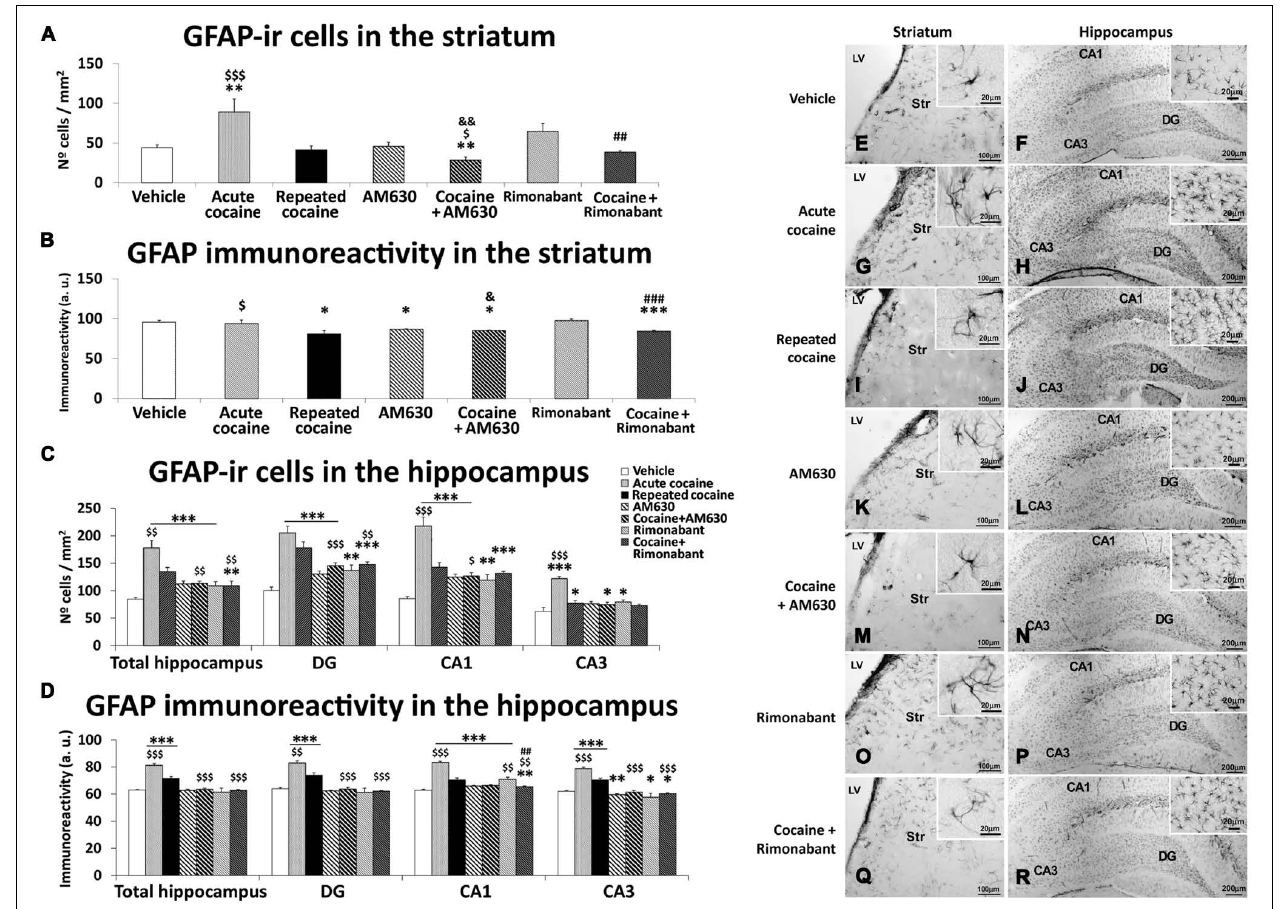
FIGURE 6 | Effects of repeated administration of cocaine and co-administration of cocaine (20 mg/kg) and Rimonabant (3 mg/kg) or AM630 (3 mg/kg) on astrogliosis in the striatum (A,B) and the hippocampus (C,D) as measured with GFAP immunohistochemistry. AM630 administration decreased the numbers of GFAP-ir cells observed in the striata of the repeated cocaine-treated rats. Both AM630 and Rimonabant induced decreases in the numbers of GFAP 3-ir cells and reduced the intensities of GFAP immunoreactivity in the hippocampi of the repeated